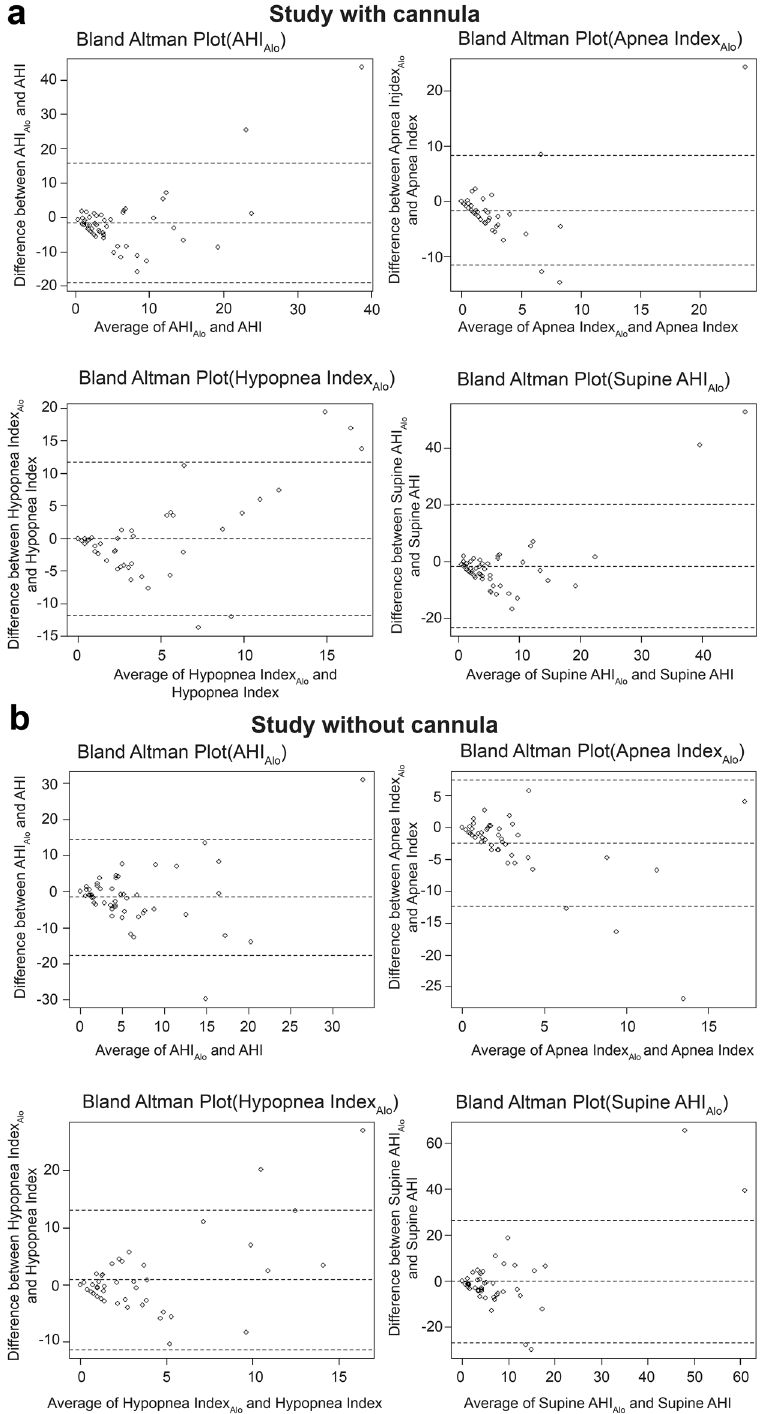
Figure 3. ( a ) Bland–Altman plots for AHI, Apnea Index, Hypopnea Index, and Supine AHI in the presence of a cannula when measuring the respiratory parameters with infrared camera alone. ( b ) Bland–Altman plots for AHI, Apnea Index, Hypopnea Index, and Supine AHI in the absence of a cannula when measuring the respiratory parameters with infrared camera alone. AHI apnea–hypopnea index, Alo infrared